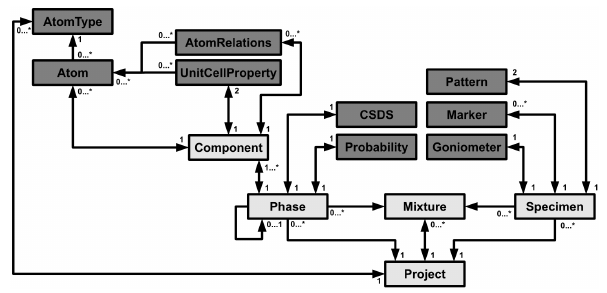
Figure 1. Schematic overview of the most important objects in PyXRD and their relations. Arrows indicate “is referenced x times by” relations and the numbers indicate the multiplicity of that rela- tion (e.g. Project holds 0 or more references to